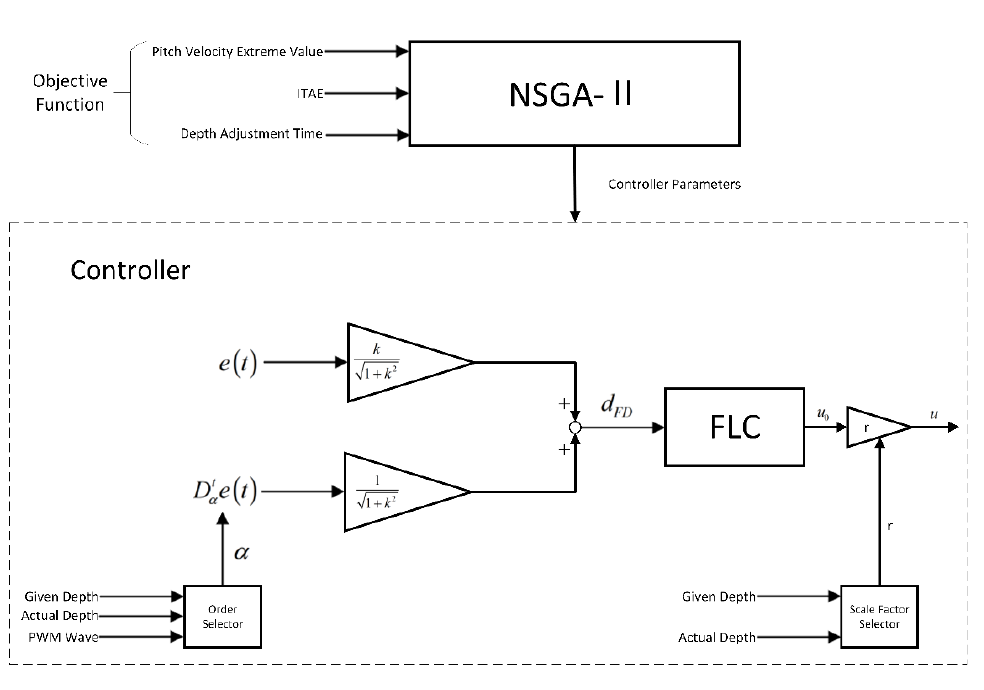
Figure 2. Structure block diagram of variable-order fuzzy logic controller with dynamic parameters.